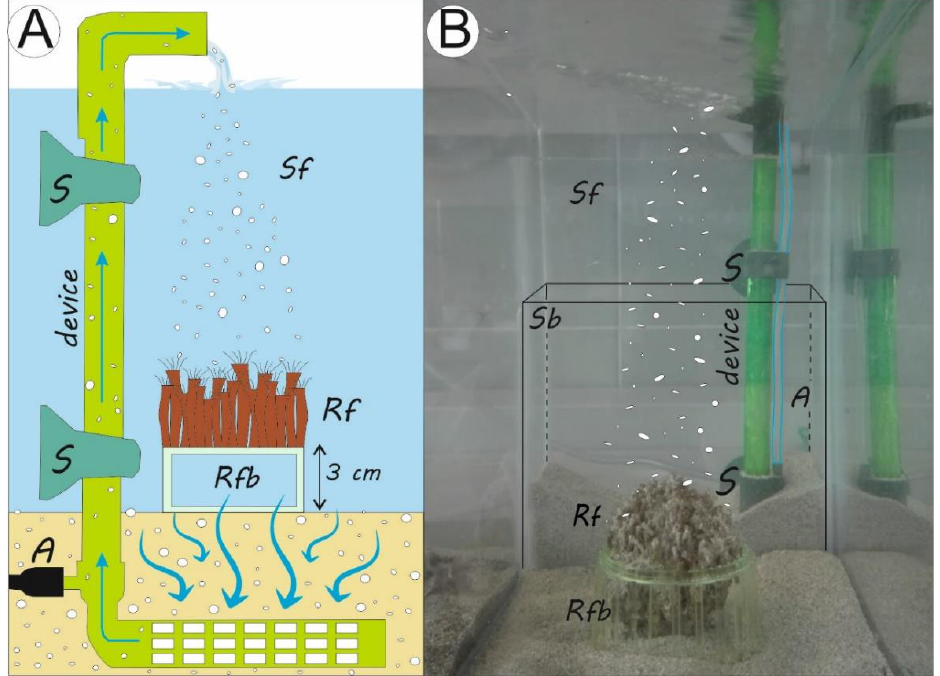
Figure 2. ( A ) Non-scale diagram of the test tank. The flow of suspended sediment (Sf) on the sample was guaranteed by a device consisting of an aerator (A) fixed by two suction cups (S) and a filter inserted in the sand box (Sb). A constant supply of particles was obtained for a very long time (a few hours). The fragment of the reef (Rf) was raised a few centimeters from the bottom and held in a fixed position (Rfb) to avoid interaction from below. ( B ) The configuration of the single test tank.